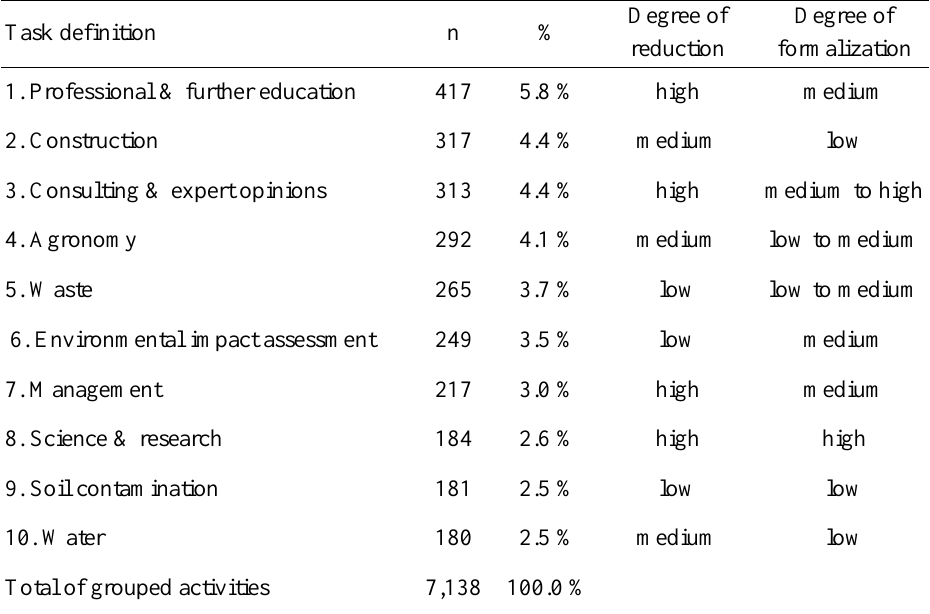
Most important categories of task definitions Task